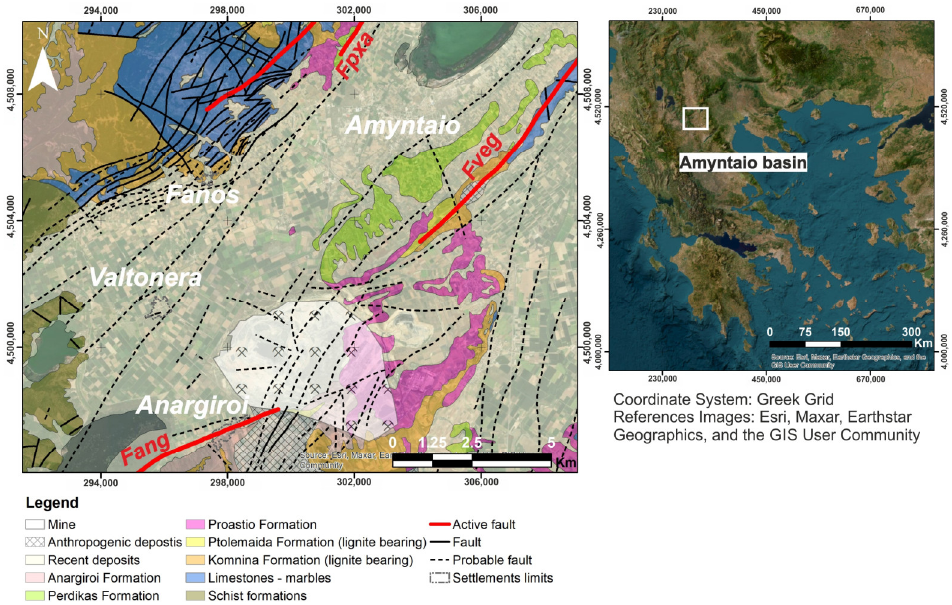
Figure 1. Geological map of the Amyntaio basin. The three active tectonic lines identified in the Amyntaio basin are clearly indicated.